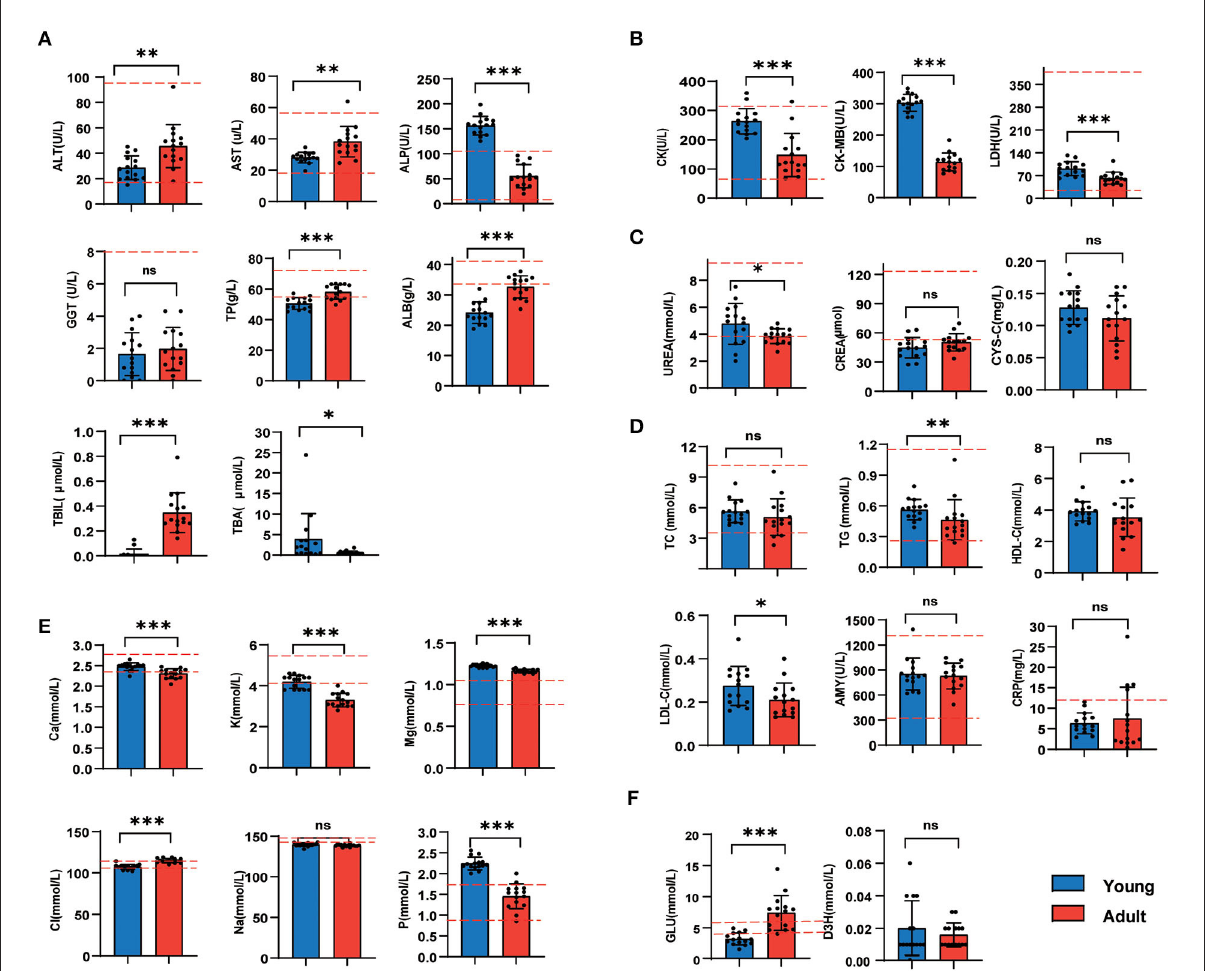
FIGURE2 Liver and heart function biomarkers were significantly separated between adult and young canines (A–E). The levels of serum biochemical indicators in young dogs and adult dogs. Measurement of liver function biomarkers (A) , heart function biomarkers (B) , kidney function indices (C) , blood lipids (D) , and blood ion concentrations (E) . (F) Fasting blood glucose and serum β -hydroxybutyrate levels were measured under overnight fasting conditions. Horizontal red dotted lines represent the normal range for each measured value. n = 15 dogs per group. Data are represented as mean and standard deviation. Adult group vs. young group: * P < 0.05, ** P < 0.01, *** P < 0.001, and ns indicates not significantly